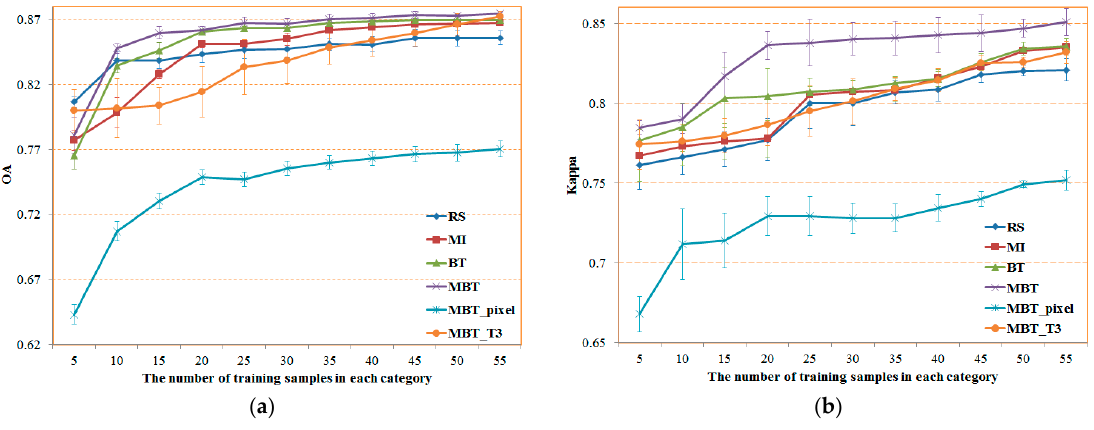
Figure 11. OA and Kappa curves with different numbers of training samples from the different strategies: ( a ) OA; ( b ) Kappa. strategies: ( a ) OA; ( b )